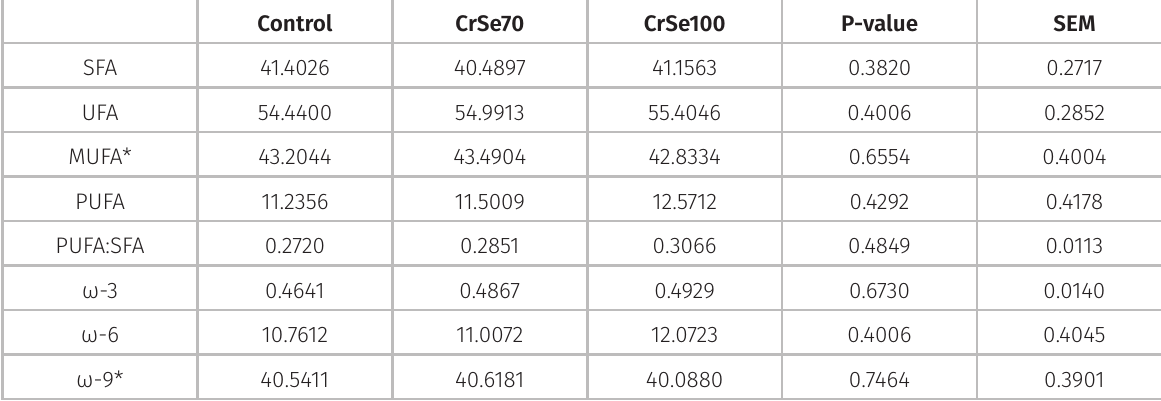
Table V. Fatty acid groups of swine supplemented with organic chromium and